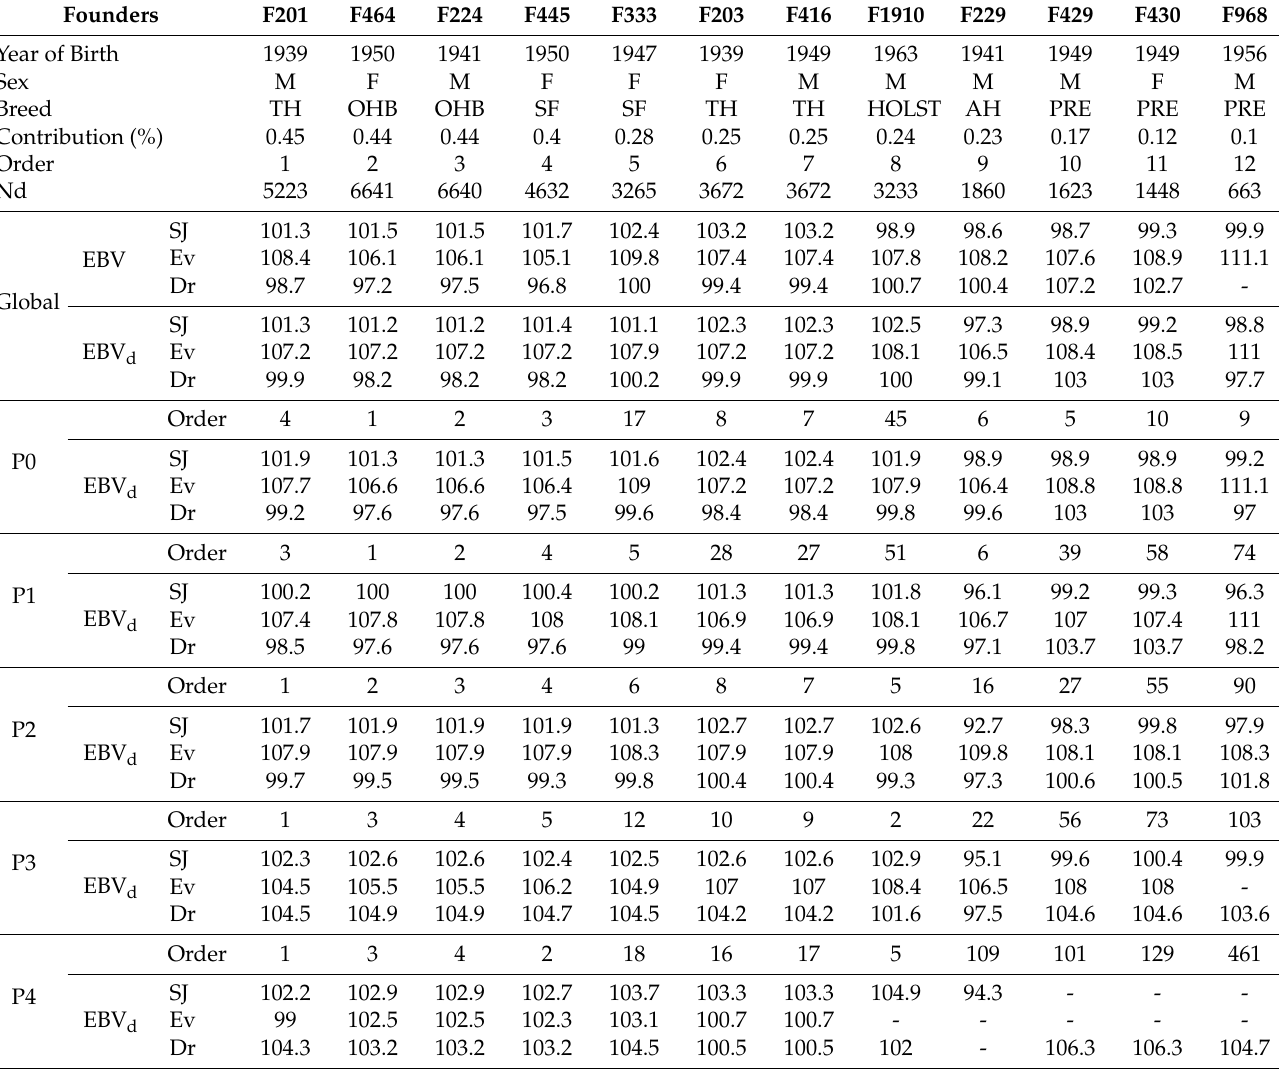
Table 3. Evolution of the genetic contribution of the twelve most contributing founders of the Caballo de Deporte Español breed in period 0, ordered by their contribution for each of the periods P1 to P4 (in percentage), with their mean estimated breeding value (EBV) and the mean EBV of its descendants (EBV d ) globally and per period, calculated based on the genetic evaluation of 2020 for Show Jumping (SJ), Eventing (Ev) and Dressage (Dr)